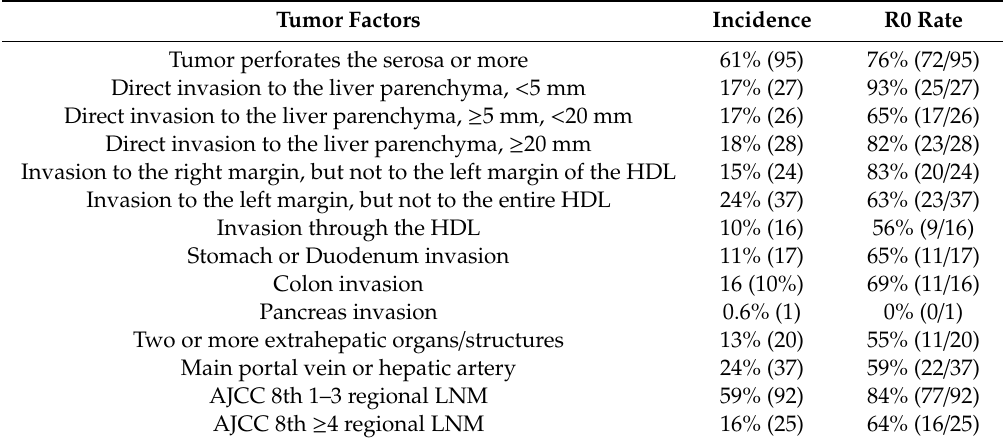
Table 1. Frequency and R0 resection rate by local factors of primary site in patients with stage 3 / 4 GBC ( n = 157) without distant